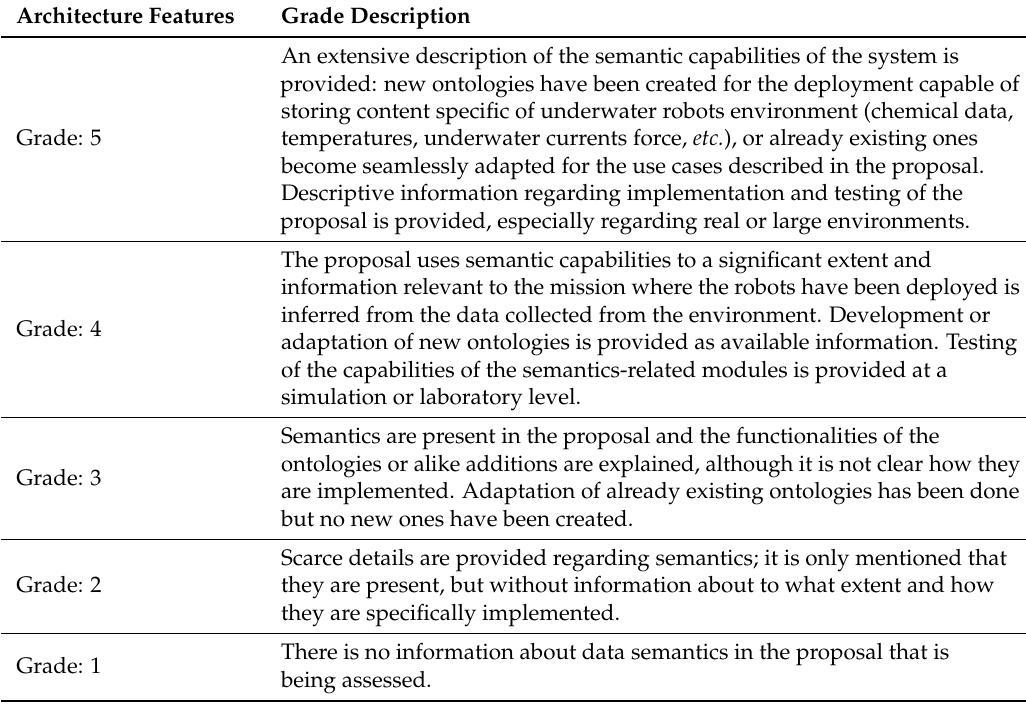
Table 3. Semantic capabilities